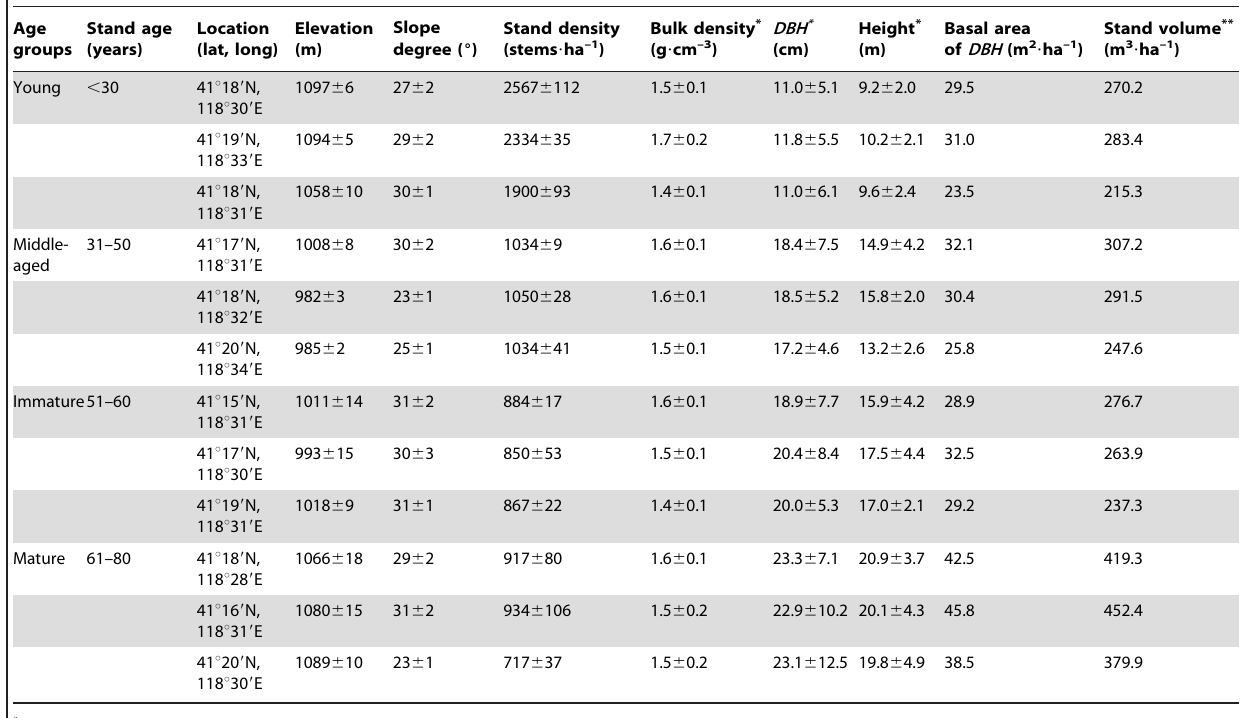
Table 1. Characteristics of stands of P. tabulaeformis natural secondary forests.